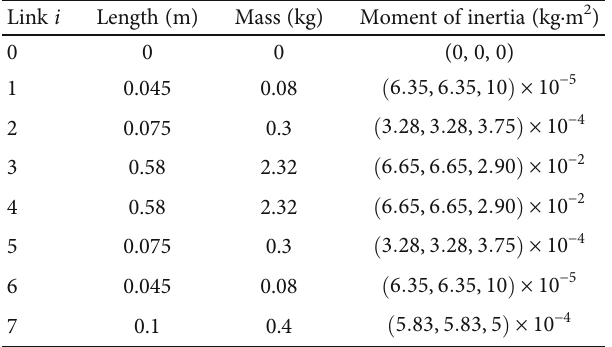
Figure 11: Training process for the RBF networks. The gray dashed line denotes the preset training goal. (a) Training process for N Training process for N . l 4 Table 4: Mass and inertia parameters of the manipulator. Table 5: The 6 designed simulation